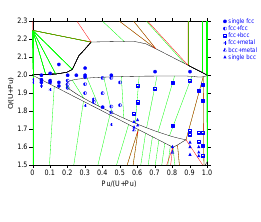
Isothermal section of O-Pu-U Isopleth of C-O-Pu-U The leftmost diagram is the O-Zr phase diagram, the middle diagram is an isothermal section at 473 K of the O-Pu-U phase diagram and the rightmost an isopleth section of the C-O-Pu-U system. Bo Sundman and Christine Gu´eneau (INSTN and DEN/DANS/DPC/SCCME, CEA Saclay)The use of Computational Thermodynamics to predict properties of multicomponent materialsDecember 5, 2012 13 /